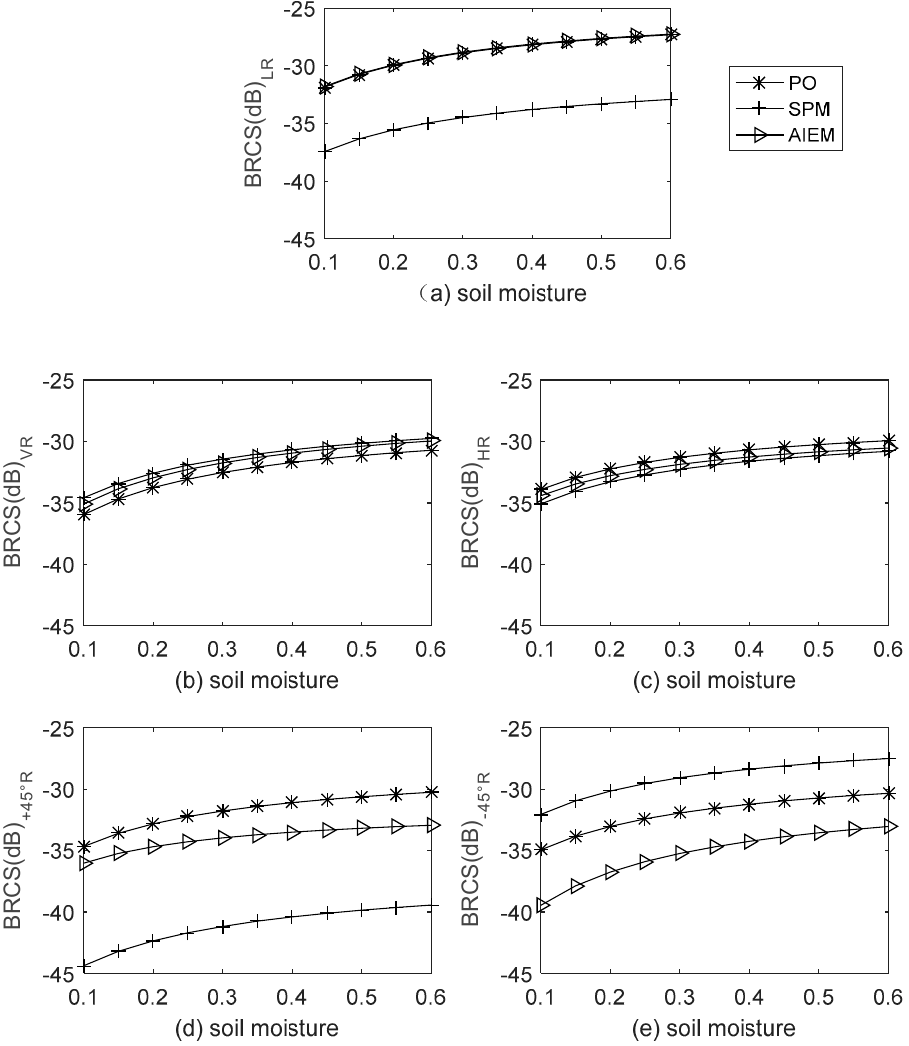
Figure 3. Soil moisture e ff ects on BRCS at five di ff erent polarizations. θ i = 30, θ s = 5, ϕ s = 120. Subfigures a to e represent the polarizations of LR, VR, HR, + 45 ◦ R and − 45 ◦ R,